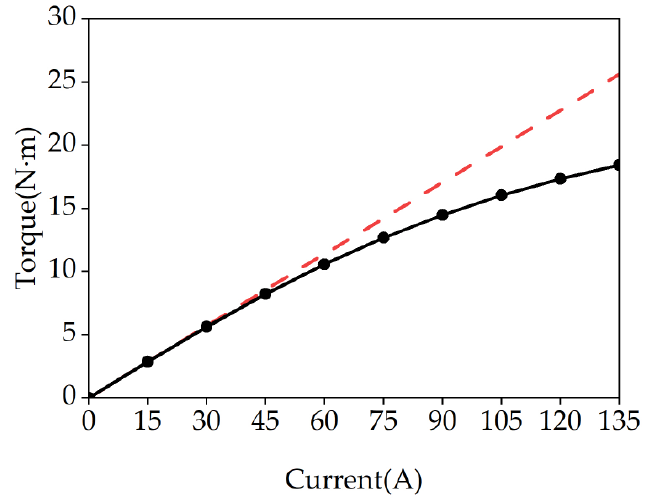
Figure 10. The load T-I curve.